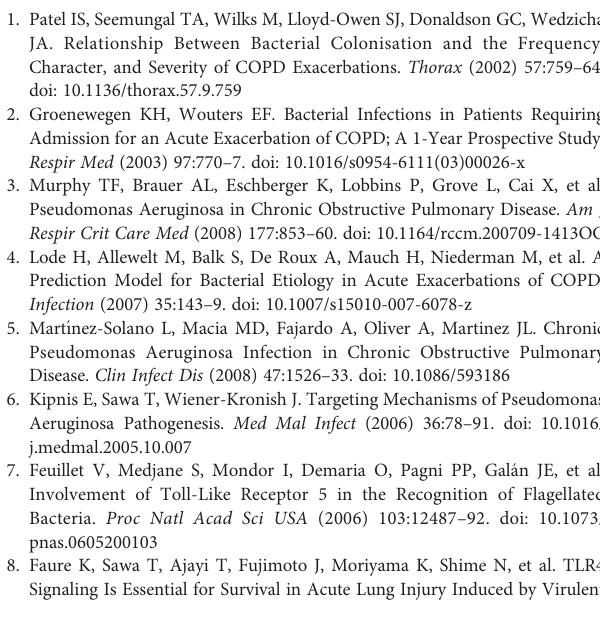
Supplementary Figure 5 | The interaction between IL-17A and RBP4 in the lungs of air-control mice in response to P. aeruginosa infection. C57BL/6 control mice that exposed to air were intraperitoneally injected with IL-17A – neutralizing antibody (2mg/kg) or recombinant – IL-17A protein (1.6 mg/kg) 4 h before the inoculation with 1.0 × 10 5 CFU P. aeruginosa (PA-air). Mouse IgG and BSA served as treatment controls, respectively. Mice inoculated with sterile agar Supplementary Figure 6 | Combination therapy of IL-17A – neutralizing antibody and antibiotic in P. aeruginosa -infected air-control mice. C57BL/6 control mice that exposed to air were intrabronchially inoculated with 1.0 × 10 5 CFU agar-entrapped P. aeruginosa . Oral cipro fl oxacin (5 mg/kg, every 12 h) was applied concurrently withintraperitoneallyadministered IL-17A – neutralizingantibody(2mg/kg,every4h) or IgG starting at 16 h post inoculation. Mouse lungs were excised, sectioned and stained with hematoxylin and eosin after treatment. The in fi ltrate scores (A) , MPO activity (B) , bacterial plate counting (C) , Ly6G + IL-17RA + cell numbers (D) , protein expression ofIL-17 (E) and IL-23 (F) , and RBP4 (G) , and spirometrytests, including FVC (H) , FEV 50 (I) , MMEF (J) , FEF 50 (K) , and FEF 75 (L) , were performed and compared between groups treated with and without IL-17A block. Data are representative of three independent experiments, and are presented as mean ± SD ( n = 3 per group). * P < 0.05, ** P < 0.01. COPD, chronic obstructive pulmonary disease; Cip, cipro fl oxacin; CFU, colony-forming units; MPO, myeloperoxidase; FVC, forced vital capacity; FEV50, volume expired in the fi rst 50 ms of fast expiration; MMEF, maximal mid-expiratory fl ow; FEF 50 , forced expiratory fl ow at 50% FVC; FEF 75 , forced expiratory fl ow at 75%